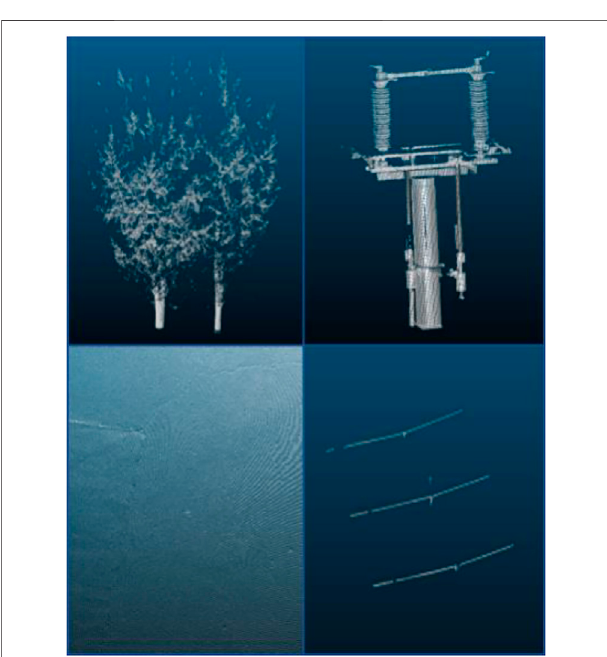
FIGURE 4 | Examples of the transmission line point cloud data set.